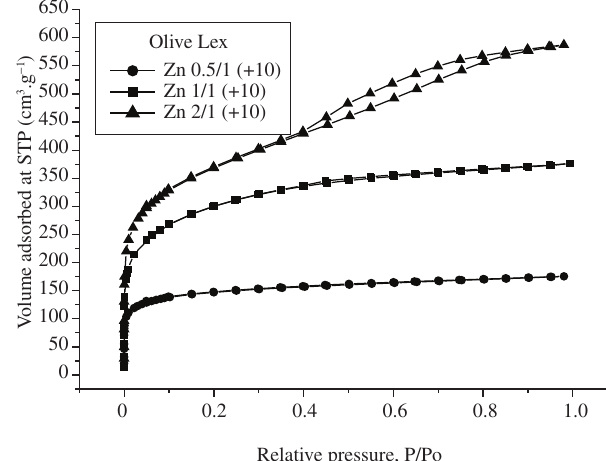
sizes.Template Figure 2. Pore Size Distribution by DFT method for the samples sieved at different mesh